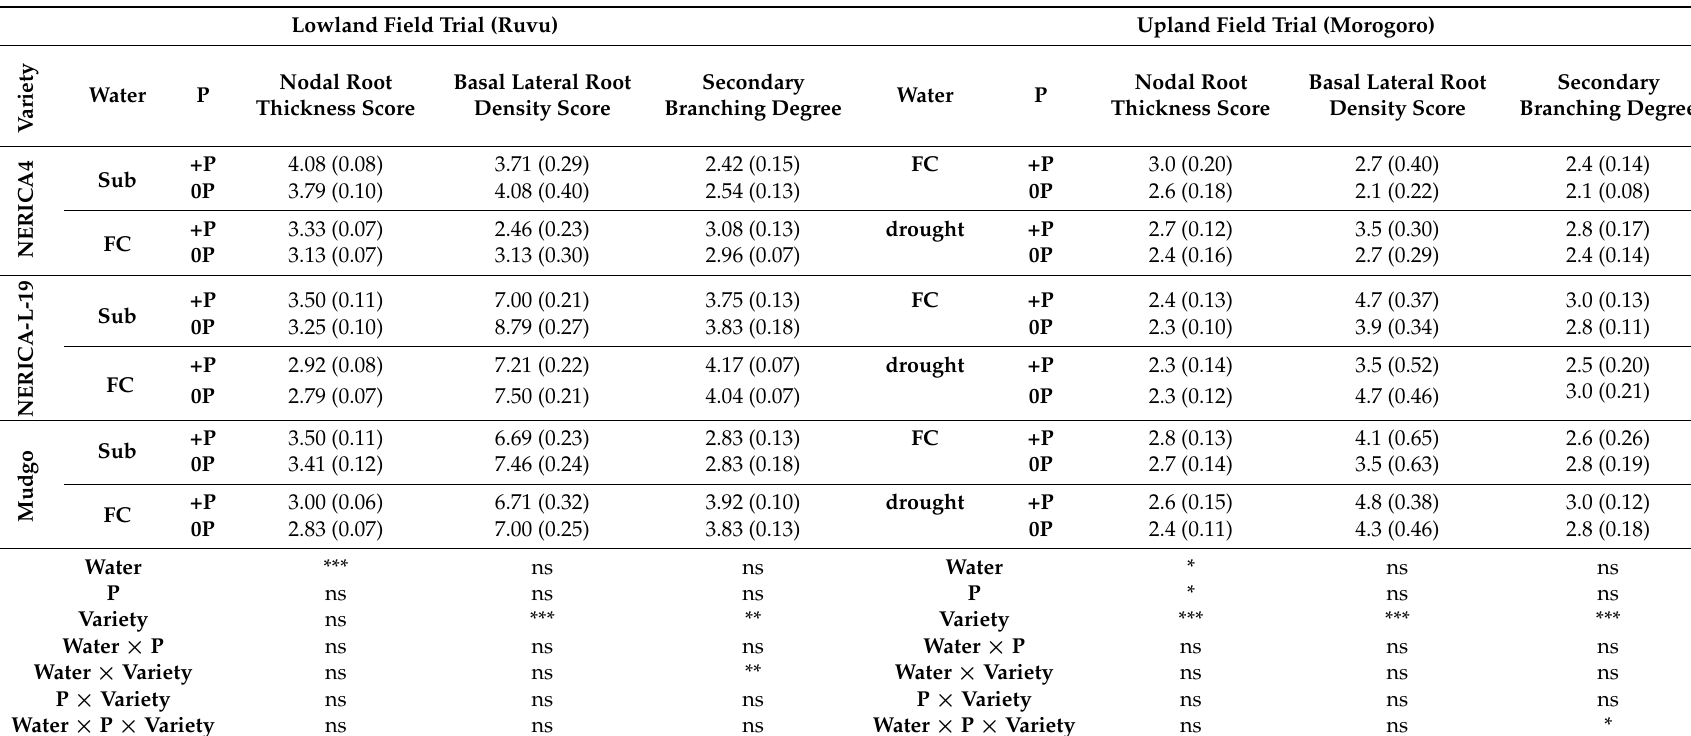
Table 7. The scores for root architectural traits (i.e., nodal root thickness score, basal lateral root density score, and secondary branching degree) of three varieties (NERICA4, NERICA-L-19 and Mudgo) grown in two field sites in Tanzania. For the lowland field, plants were grown under two different P rates (0 kg P ha − 1 (0P) versus 30 kg P ha − 1 (+P)) and two different water treatments (field capacity (FC) versus submergence (Sub)). For the upland field, plants were grown under the